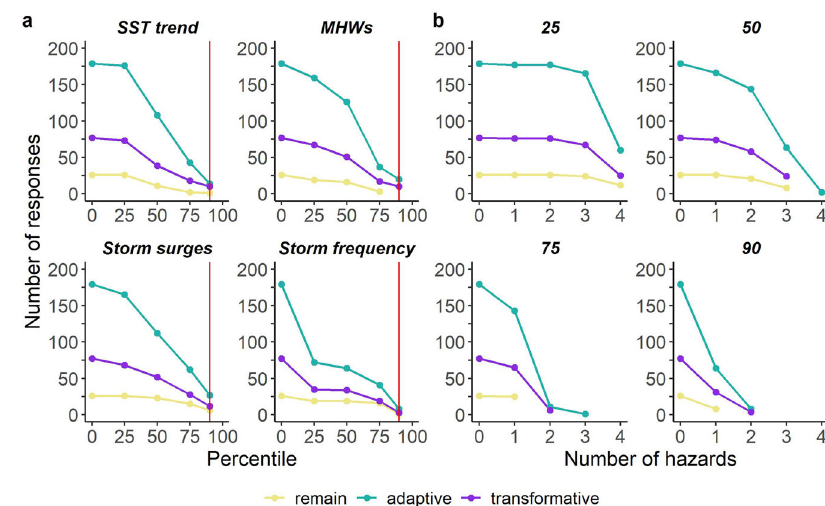
Fig. 4 Types of responses of small-scale fi shers in relation to climate change exposure. The responses were categorized following the adaptive – transformative framework of ref. 24 . a Number of responses found in the literature geographically overlapping regions at four different exposure thresholds (percentiles 25th, 50th, 75th, and 90th) of long-term rate of change in sea-surface temperature (SST) (1982 – 2018), cumulative intensity of marine heatwaves (MHV) (1982 – 2018), estimates of extreme sea levels associated to storm surges (1974 – 2014), and frequency of tropical storms (1980 – 2018). We used the full set of responses ( n = 281) that presented coordinates to calculate the number of responses overlapping each hazard exposure level. The number of responses per hazard type per the corresponding threshold is provided in Supplementary Data 2. b Number of responses found in regions exposed at least to 1, 2, 3, and 4 cumulative hazards at four exposure levels (percentiles 25th, 50th, 75th, and 90th). Cero equals the total number of responses ( n = 281). The full set of responses was used for the calculation of responses overlapping each cumulative hazard number using a buffer radius of 100 km. The number of responses of each response type per cumulative hazard number for all exposure levels is provided in Supplementary Data 3. The vertical red line indicates the hotspot threshold (90th